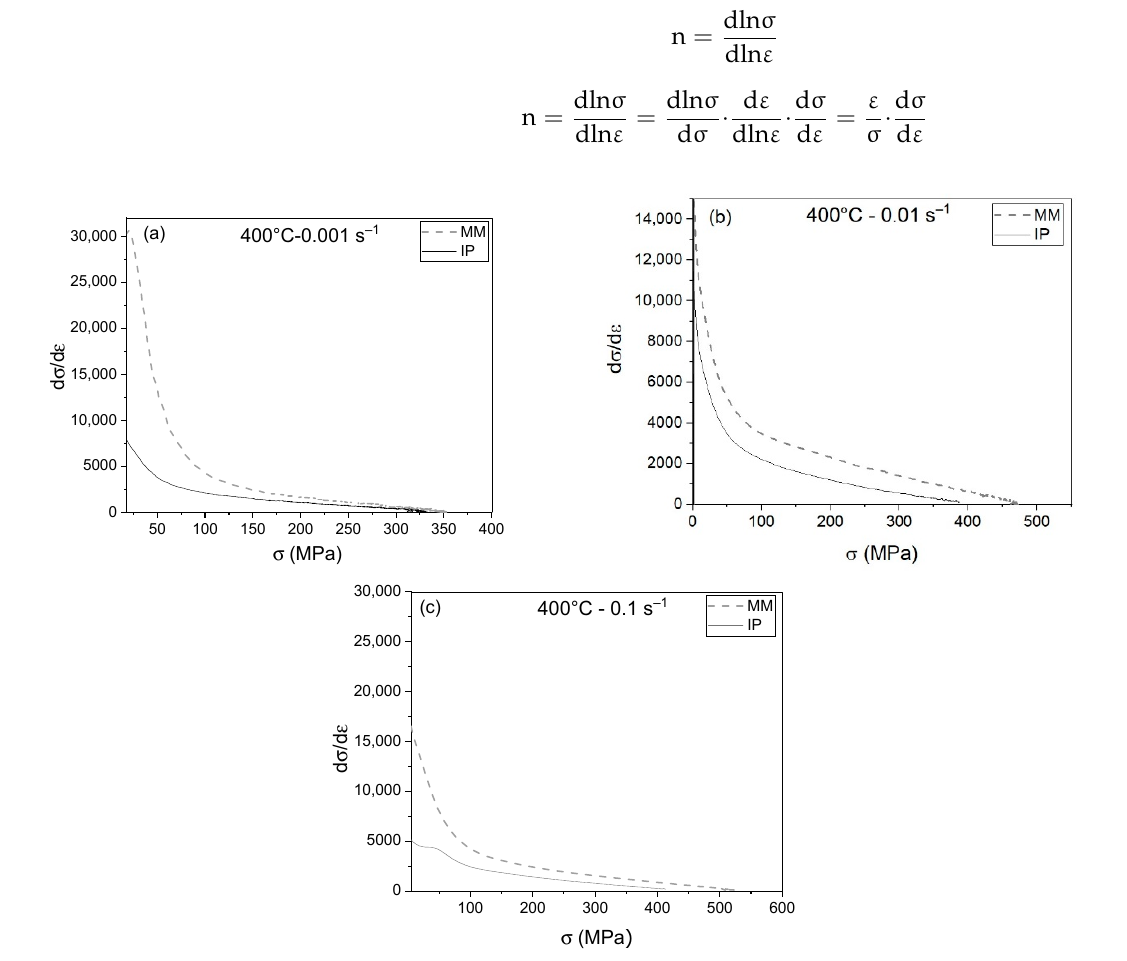
Figure 5. Strain hardening rate d σ /d ε vs. σ of IP and MM samples at 400 °C and different strain rates. ( a ) 0.001 s − 1 ; ( b ) 0.01 s − 1 ; ( c ) 0.1 s − 1 .